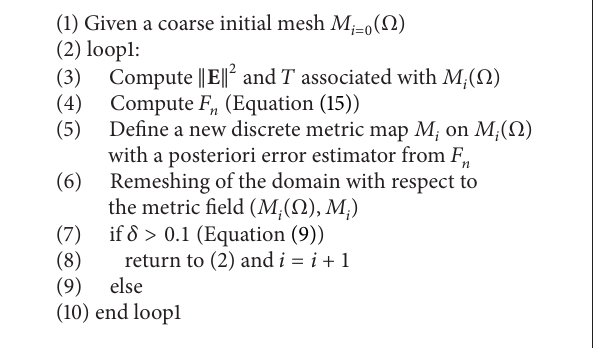
Algorithm 3: Algorithm of adaptive remeshing strategy 𝐴 3